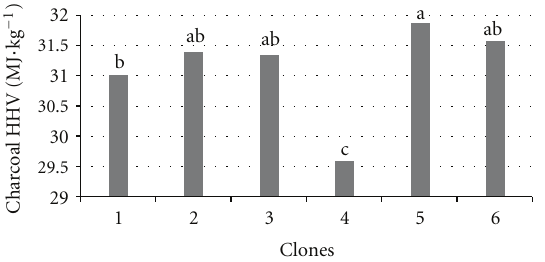
Figure 5: Mean values of charcoal higher heating value (HHV) of Eucalyptus spp., in MJ · kg − 1 . Standard deviation = 0.80; variation coe ffi cient = 2.6%. Means followed by same letter do not di ff er at 5% probability by Tukey test. Figure 6: Energetic density of charcoal and wood, in MJ · m − 3 .